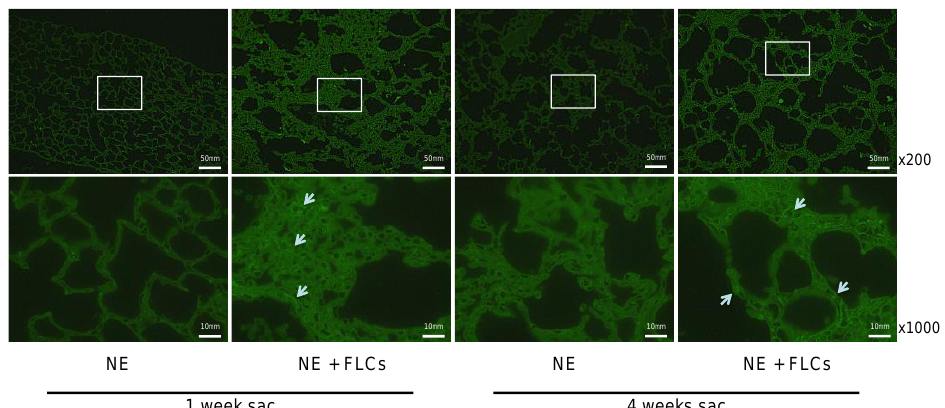
Figure 3. Representative lung sections showing under a fluorescence microscope from 1 week or 4 weeks after the NE administration with or without FLCs transfer. NE: neutrophil elastase, FLCs: fetal lung cells sac: sacrifice. White box shows the enlarged part and the arrows indicate GFP-positive cells.